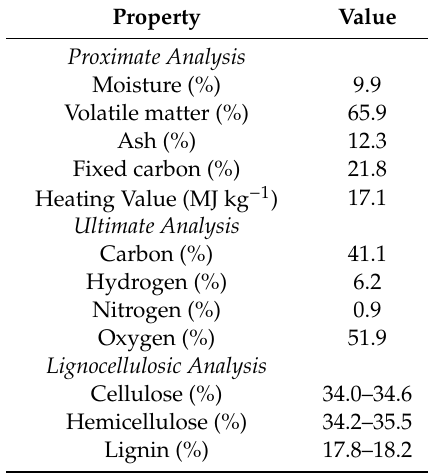
Table 1. Relevant physicochemical properties of pigeon pea wood used in this study